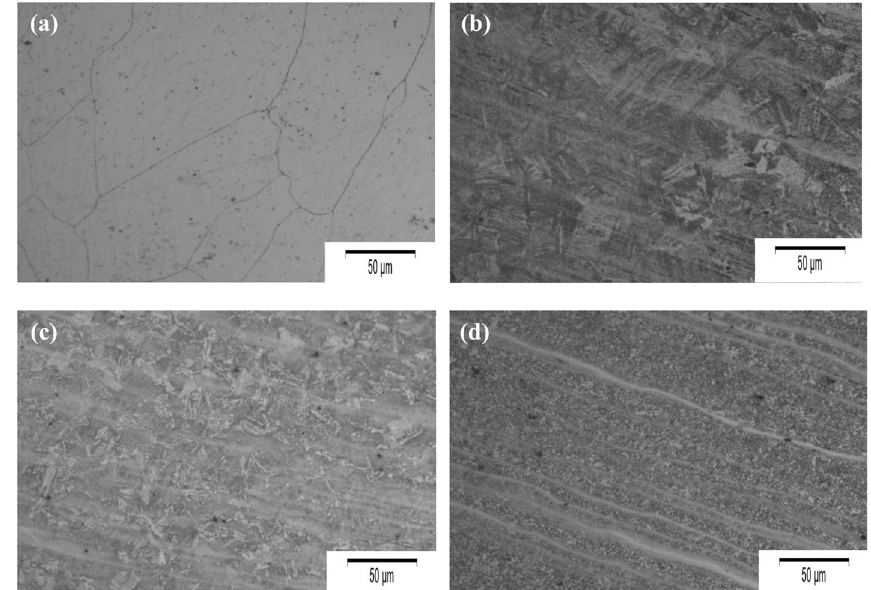
Fig. 22 Microstructure of single V welded joint using AWS A 5.9 ER 307 filler metal. a Weld metal. b Martensite structure in weld metal zone. c Grain coarsening martensite structure in HAZ zone. d Over-tempering (softening zone) in HAZ zone